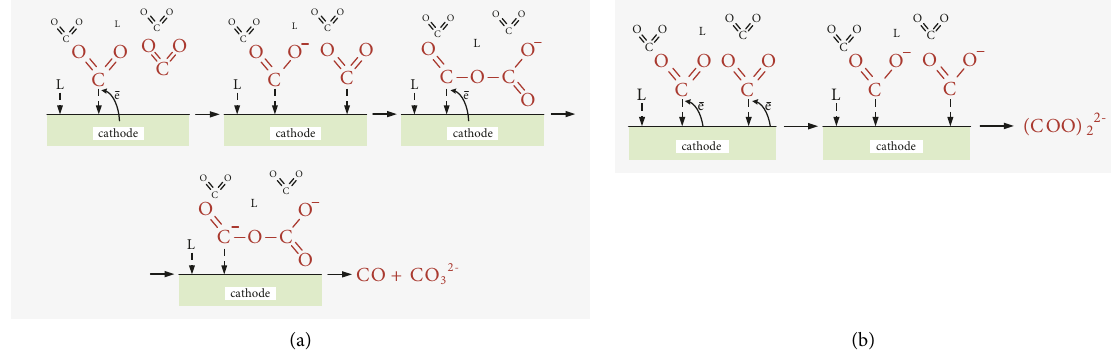
Figure 5: Scheme of cathod f reduction of CO